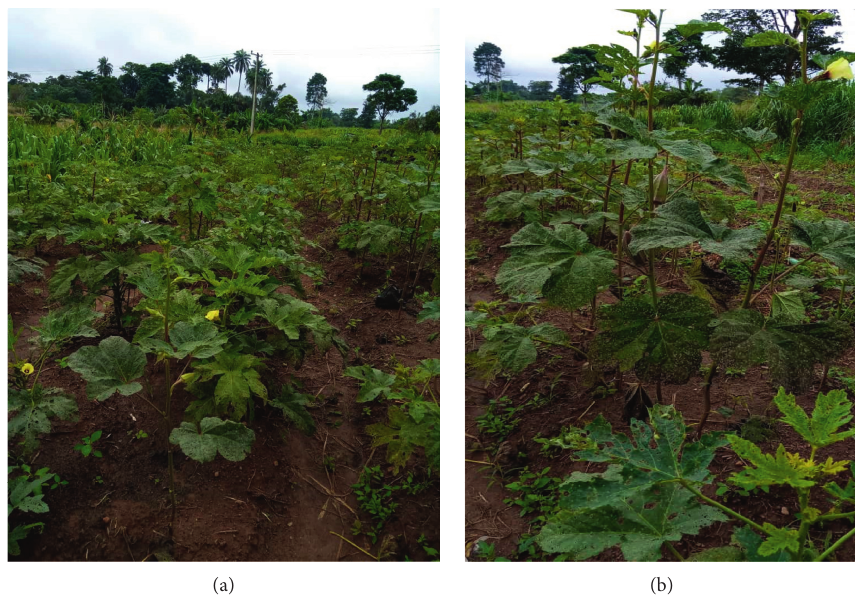
Figure 3: Okra plant at flowering stage on the